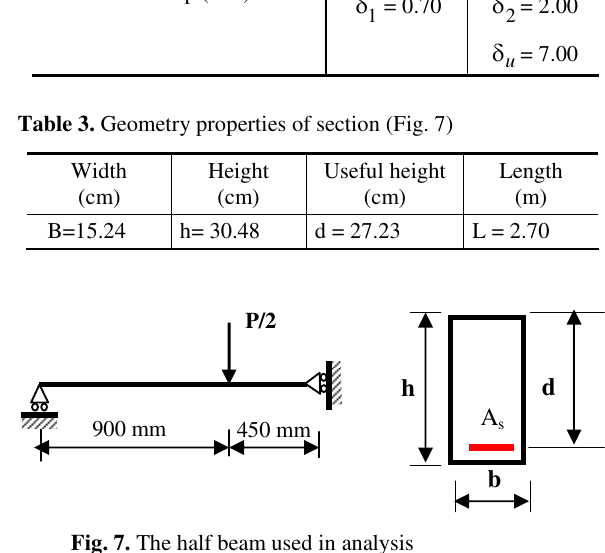
Fig. 7. The half beam used in